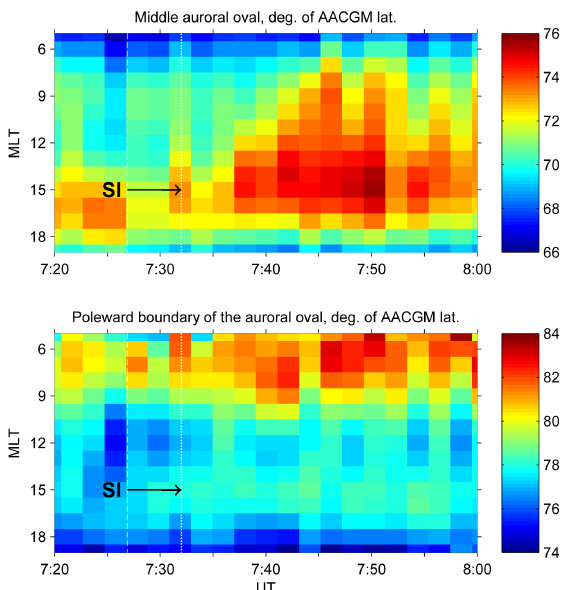
Fig. 4. Locations of the auroral oval middle part and the auro- ral oval poleward boundary in various MLT sectors as a function of universal time. White vertical dashed and dotted lines indicate mo- ments of the pressure pulse arrival at the bow shock and its detection at the low-latitude magnetic observatory Bangui, respectively. After the SI, the middle part of the auroral oval was progressing poleward (top panel). Motion of the poleward boundary of the auroral oval (bottom panel) is less prominent.